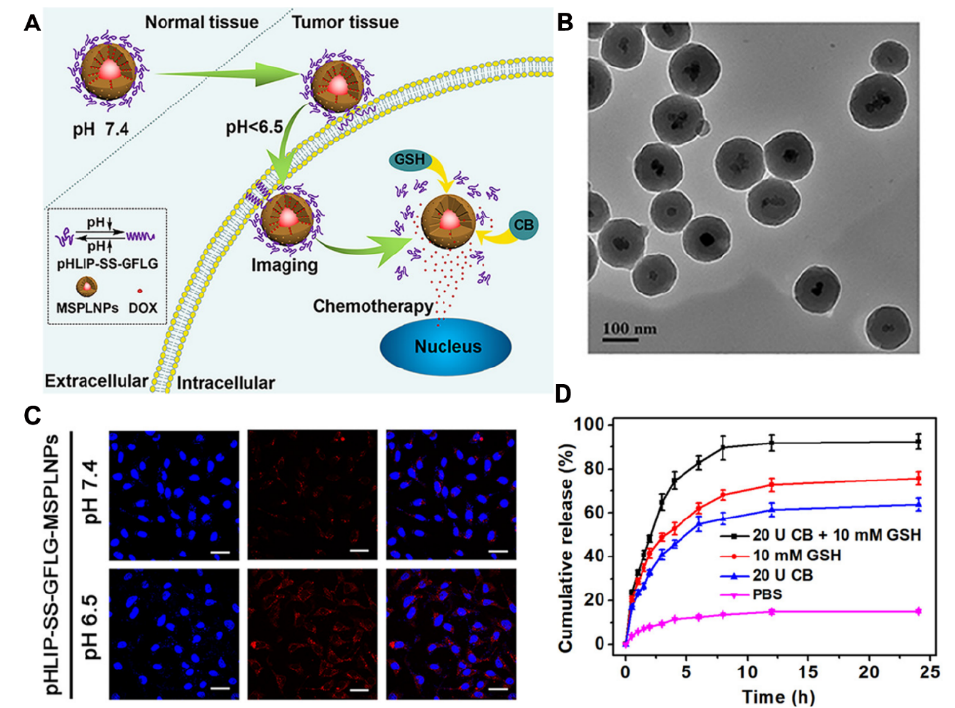
Figure 12. ( A ) Schematic illustration of DOX-loaded zinc gallogermanate (ZGGO)@mSiO 2 @GFLG-SS-pHLIP composed of persistent luminescent nanoparticle (PLNP)/MSN core/shell structure, glutathione/cathepsin B dual-responsive polypeptide coating (pHLIP-SS-GFLG) and anticancer drug (DOX). This nanosystem is designed to achieve drug delivery under glutathione or/and cathepsin B conditions. ( B ) TEM image of ZGGO@mSiO 2 . ( C ) Confocal laser scanning microscopy images of stained A549 cells, ZGGO@mSiO 2 @GFLG-SS-pHLIP, and merged (from left to right). ( D ) The drug release profile of DOX-loaded ZGGO@mSiO 2 @GFLG-SS-pHLIP in PBS buffer solution with or without stimulus (glutathione and cathepsin B). Adapted with permission from reference [147] . Copyright (2020) American Chemical Society.